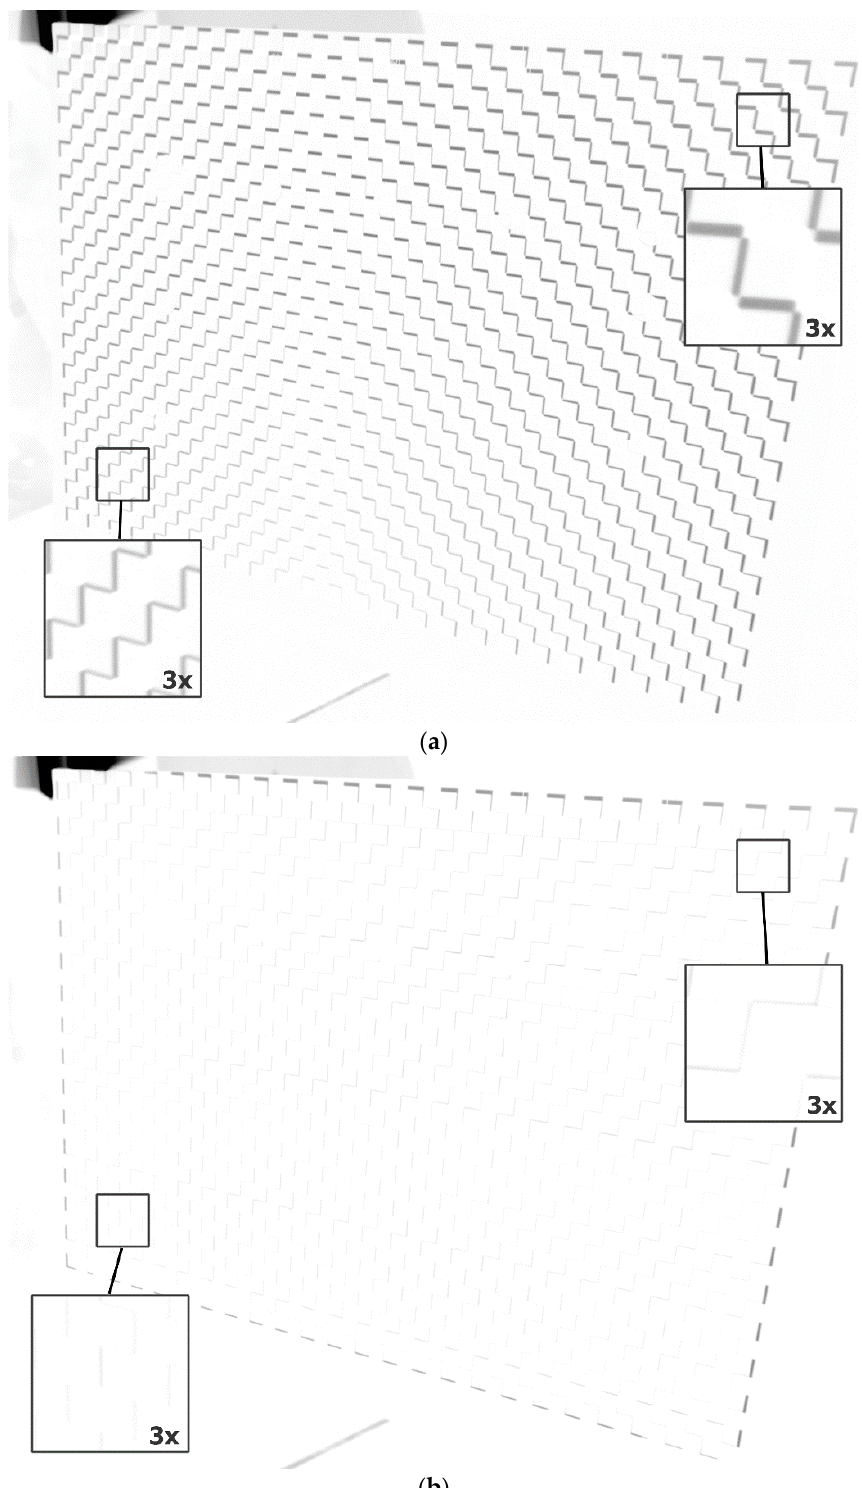
Figure 16. Qualitative demonstration of the effect of the calculated compensation model on the LightCrafter 4500 projector: ( a ) The presented image is the result of subtracting (and intensity inversion) two frames collected at reference temperature 42 ℃ and the temperature of 55 ℃ when projecting a black and white checkerboard pattern, without compensation of the projected image; and ( b ) the same frame subtraction, but with compensation of the projected image.